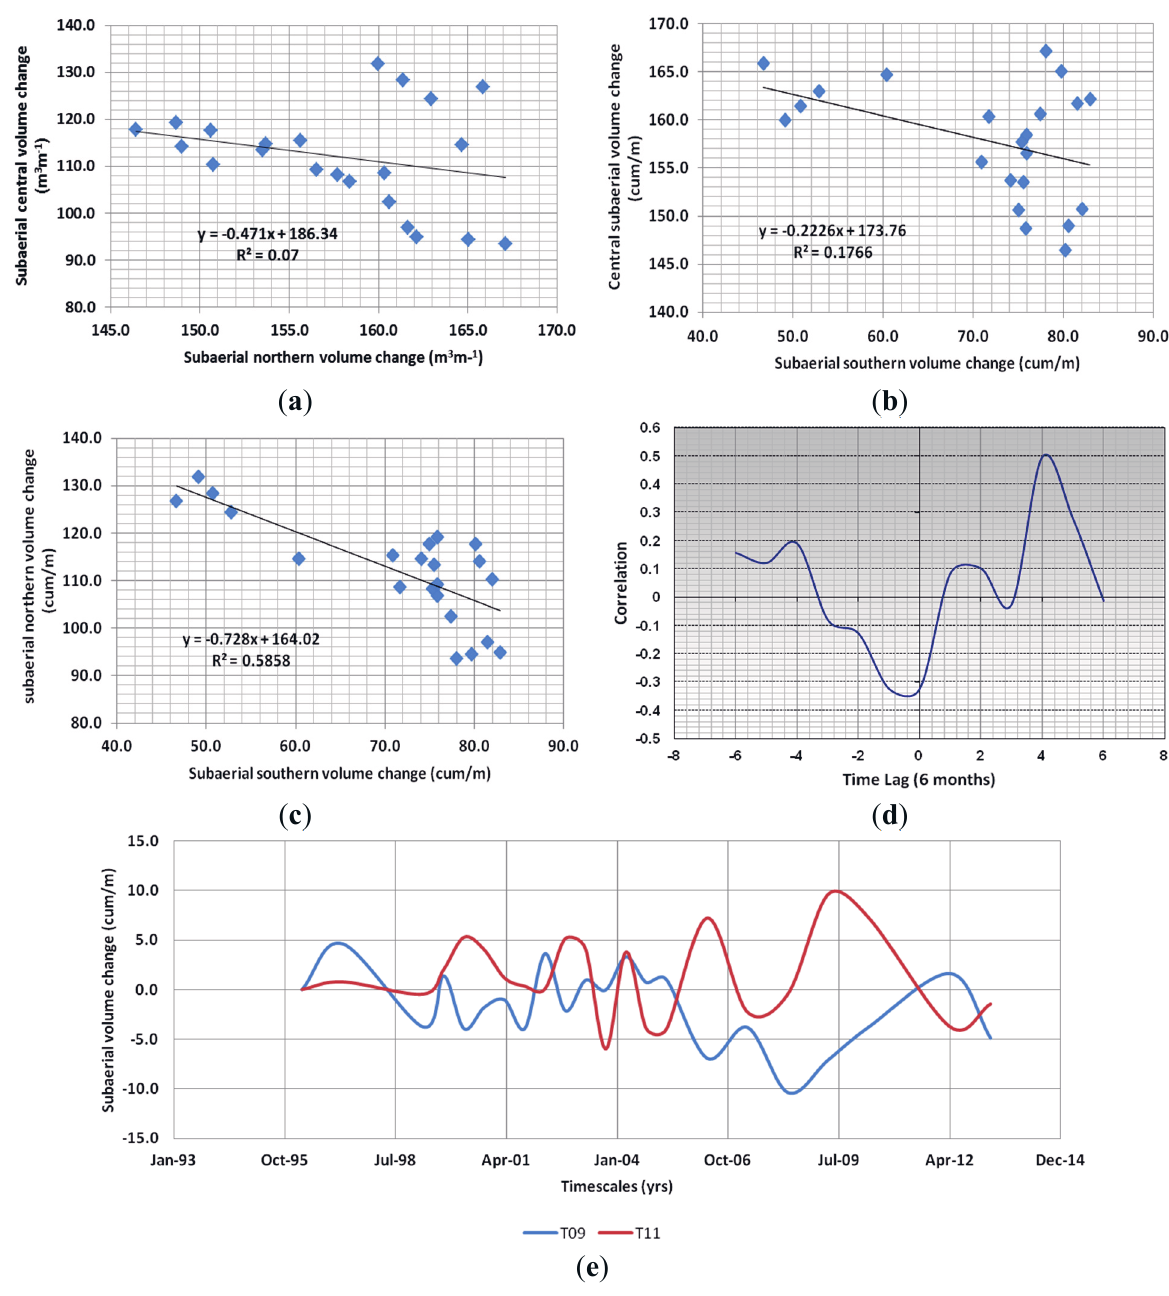
Figure 5. Analyses of transformed beach subaerial volume trends 1996–2013: ( a ) between south and north beach extremities; ( b ) between southern and central zones; ( c ) between northern and central zones; ( d ) cross-correlation results between south and north beach extremities; and ( e ) a graphical representation depicting temporal inter-survey volume